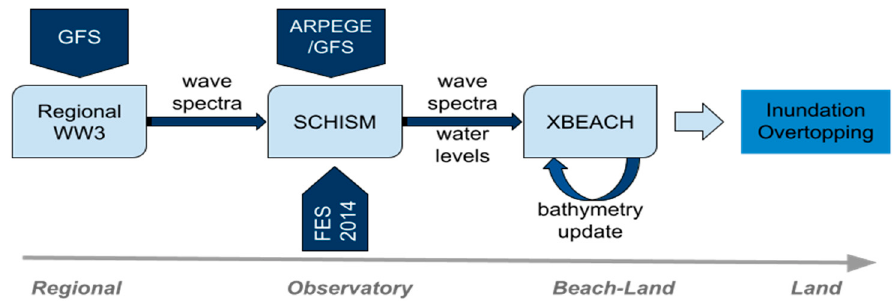
Figure 1. Model Chain Workflow.